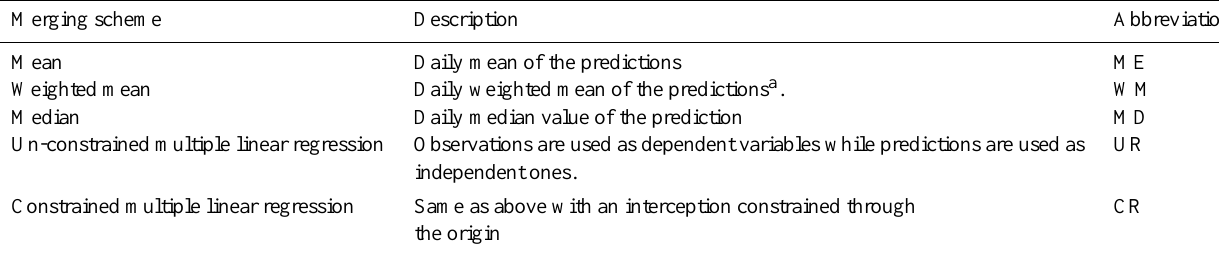
Table 3. Goodness-of-fit indicators of calibrated models runs for daily runoff prediction between 1 January 2000 and 31 Decem- ber 2004 (best achieved values are highlighted in